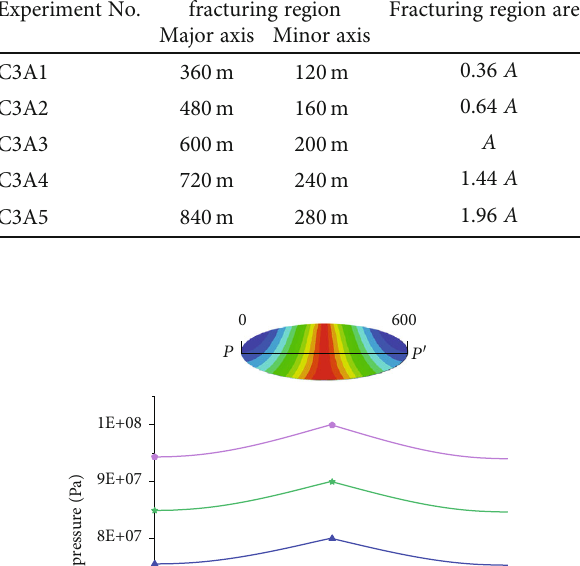
Table 10: Numerical experiments according to di ff erent fracturing region areas. Experiment No.